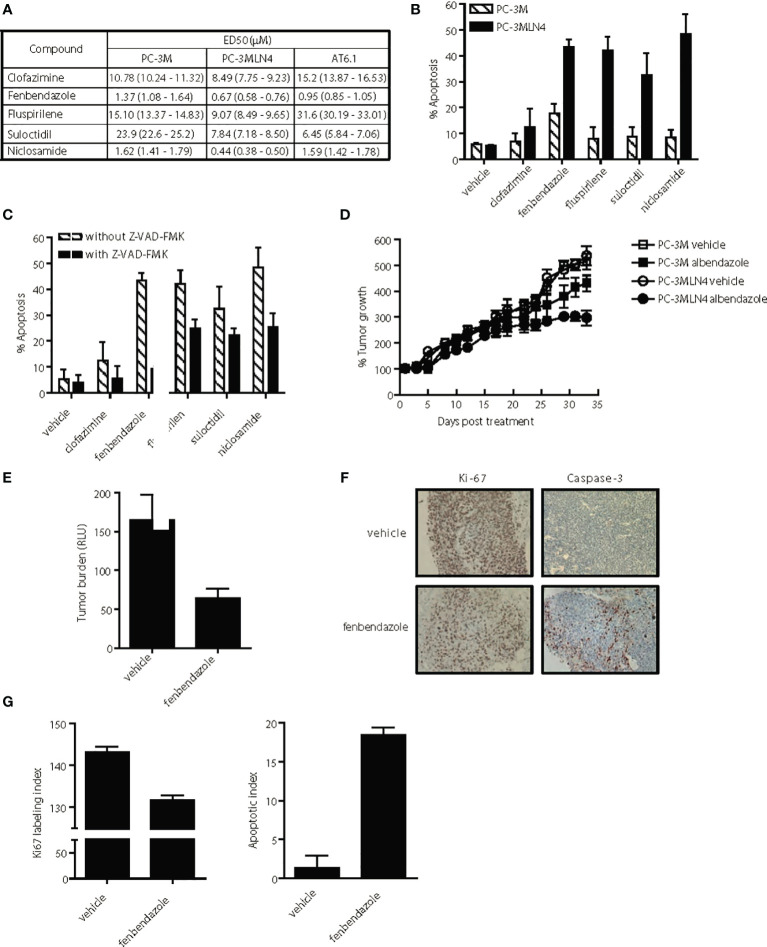
Selective anti-tumor activity of lead hits on highly aggressive, metastatic prostate cancer cells. (A) ED50 of agents for highly metastatic (PC-3MLN4 and AT6.1) and less metastatic (PC-3M) prostate cancer cells after 72 h treatment, as determined using Cyquant proliferation assay. Data shown are mean ± 95% confidence interval, N=3 per group. (B) Percent apoptosis was determined by annexin V-stained cells after 72 hr treatment with 1 μM drug. Data shown are mean ± 95% confidence interval, N=4 per group. PC-3MLN4 were significantly (p < 0.01) more apoptotic than PC-3M when treated with fenbendazole, fluspirilene, suloctidil, and niclosamide. (C) Drug-induced apoptosis in PC-3MLN4 was significantly (p < 0.05) reduced by treatment with 20 µM caspase-3 inhibitor (Z-VAD-FMK) for fenbendazole, fluspirilene, and niclosamide. (D) PC-3M and PC-3MLN4 subcutaneous tumors were treated with 100 mg/kg fenbendazole, three times a week for five weeks. Percent tumor growth was calculated from the tumor volume measured on first day of treatment. Data shown are mean ± 95% confidence interval, N=10 per group. Tumor growth was significantly (p < 0.01) more reduced in PC-3MLN4 treated with FBZ (44.9%) than in PC-3M treated with FBZ. (E–G) AT6.1 cells were inoculated via tail vein 5 days prior to treatment with 100 mg/kg fenbendazole, given 3 times a week until day 22 when signs of morbidity were observed in the control group. (E) Secreted Gaussia luciferase activity in the peripheral blood, indicative of tumor burden in the mice was measured on the day of harvest, p < 0.001. (F) Representative staining of Ki-67 and activated caspase-3 on tumors in the lungs. (G) Ki-67 labeling and apoptotic index was determined using Imagescope software (Aperio). N=10 mice/group, p < 0.001.